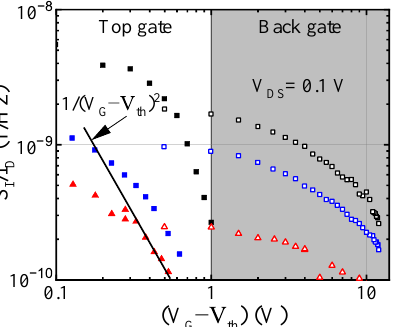
Figure 7. Spectral noise density S I / I 2 at frequency f = 10 Hz as a function of either top or back gate D voltage swings (V G − V th ) for three transistors with different channel dimensions, while keeping the other gate voltage equal to zero. Filled symbols correspond to the top gate voltage; open symbols are for back gate